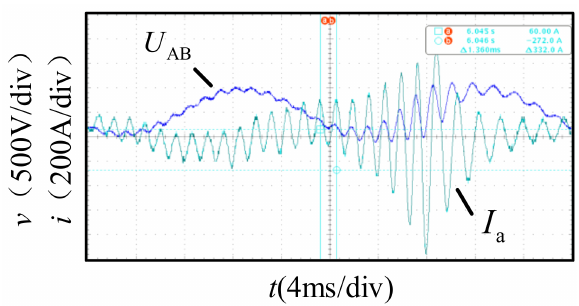
Figure 17. Experimental waveform of single inverter before control.